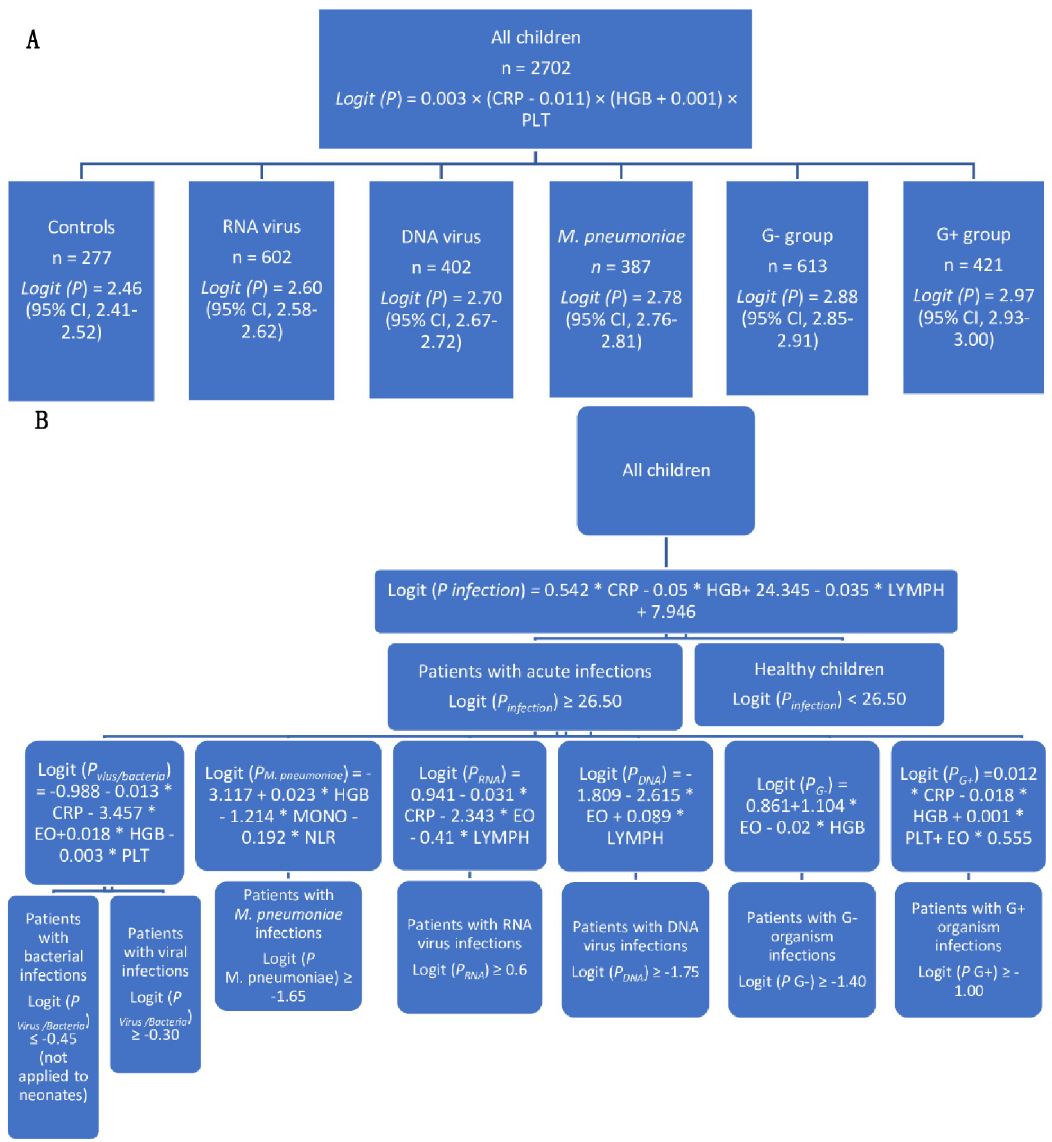
Fig 3. A, Logistic regression-based model for distinguishing among the six groups. B, Flow chart of the recommended used of the formulae in routine clinical